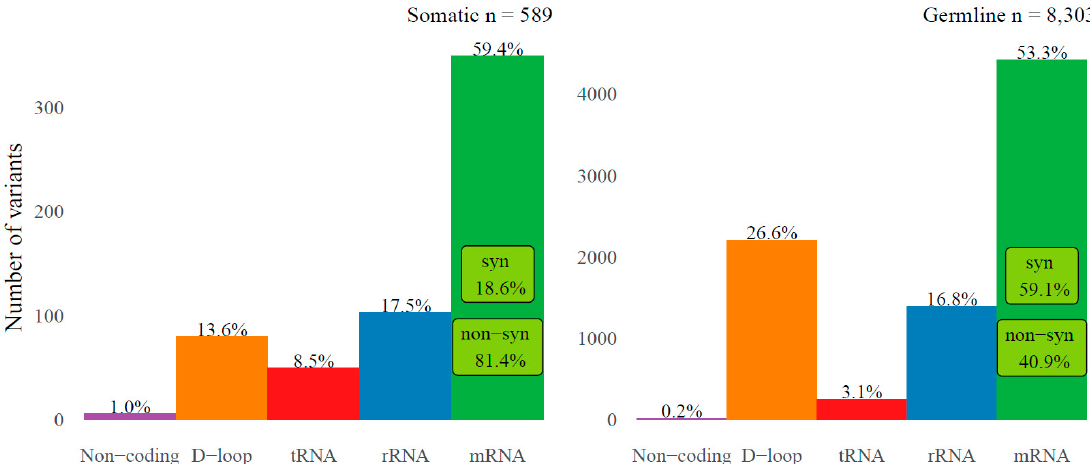
Figure A3. Genomic distribution of mitochondrial DNA variants of 381 primary breast tumor cases. Genomic distribution is depicted for somatic (left) or germline (right) variants in either non-coding (purple), the D-loop (orange), tRNA (red), rRNA (blue) or mRNA (green) regions of the mitochondrial genome. The percentage of total is indicated at the top of the bars. The percentage of substitutions in the mRNA regions with either a synonymous or nonsynonymous effect is indicated within the mRNA bar (light green).